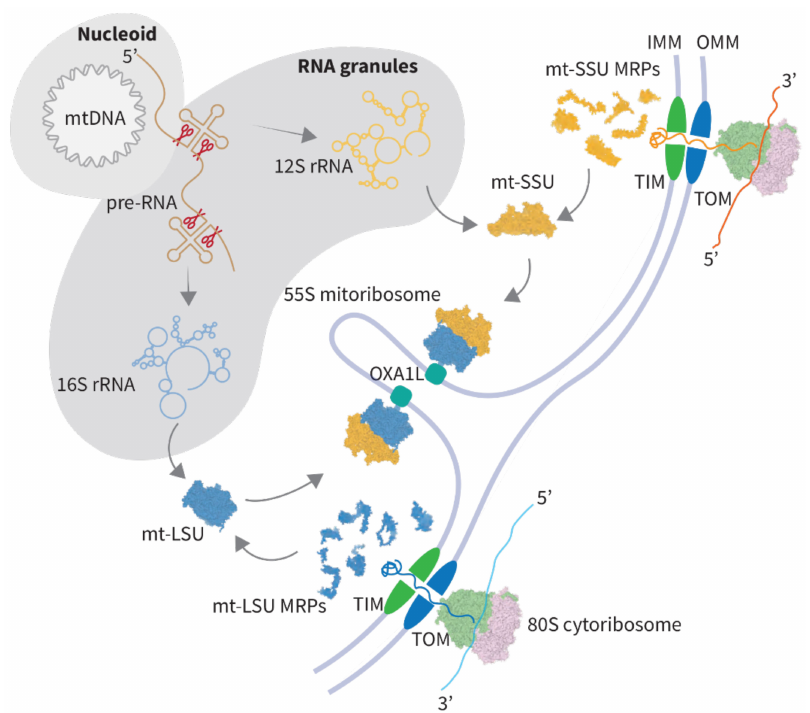
Figure 1. Biogenesis of the mitoribosome. The mitoribosome is composed of mitoribosomal proteins (MRPs) and RNAs, which are produced in the cytosol and mitochondria, respectively. The RNA components are derived from the transcription of mtDNA in nucleoids, followed by the RNA matu- ration in RNA granules. MRPs are synthesized by the 80S cytosolic ribosome and imported into the mitochondrial matrix through the mitochondrial import machinery (TOM and TIM proteins). Next, MRPs and rRNAs are assembled into the mitochondrial large subunit (mt-LSU) and the mitochon- drial small subunit (mt-SSU). The complete 55S monosome is anchored to the inner